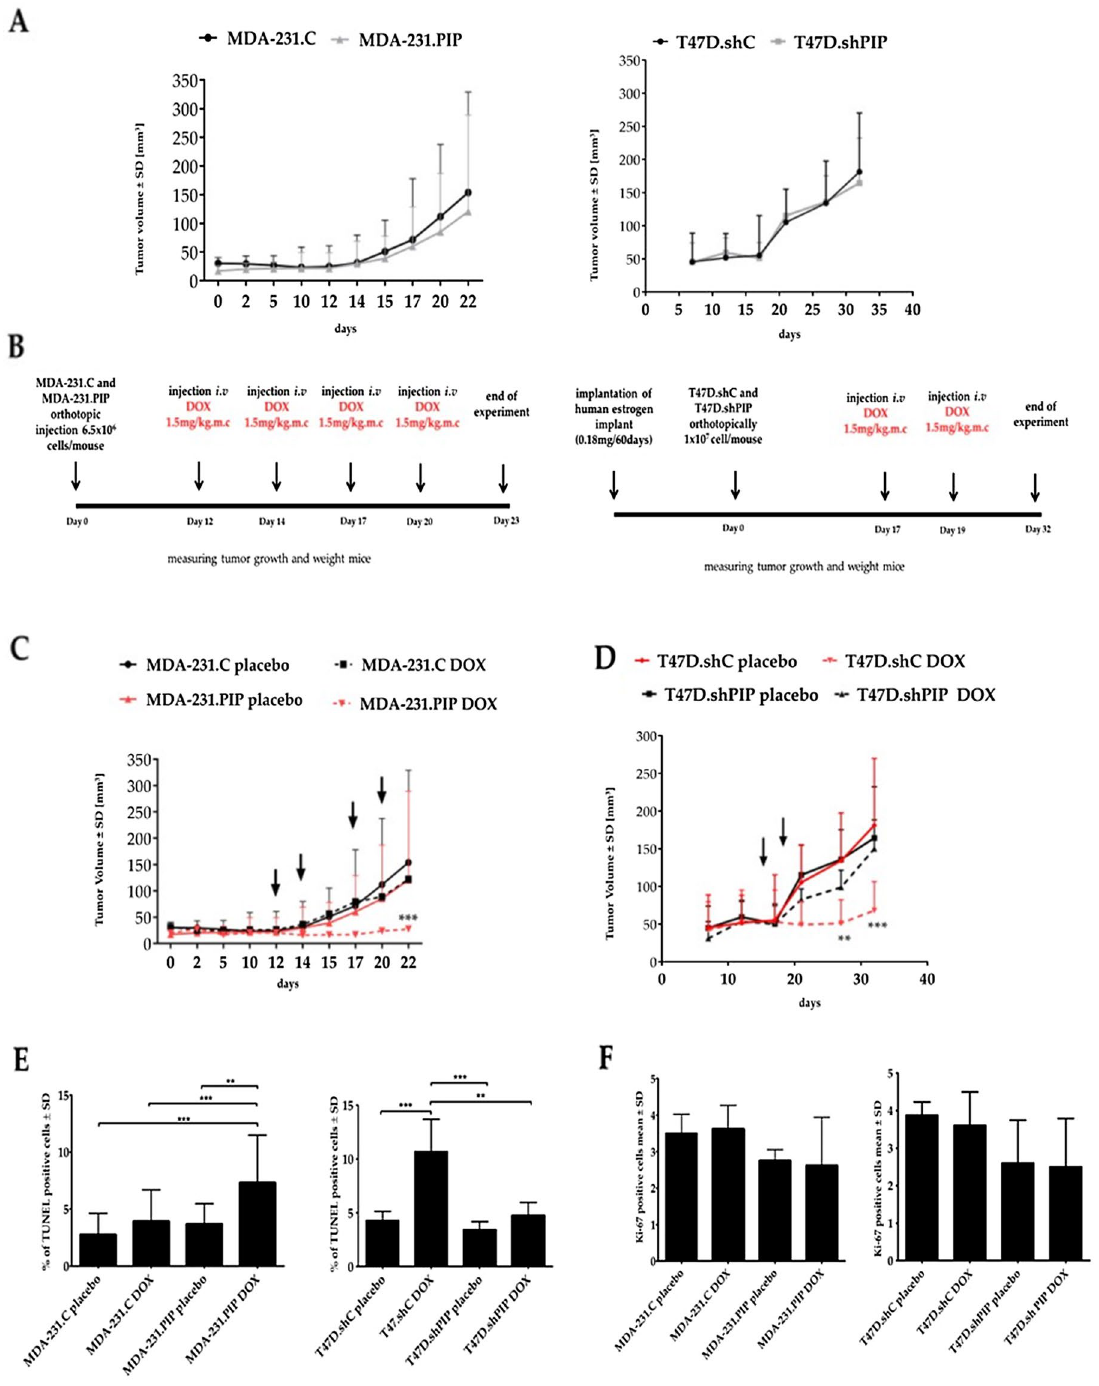
Figure 4. ( A ) Xenograft tumor growth of MDA-231.PIP with overexpression of PIP and control MDA-231.C; T47D.shPIP with the suppressed expression of PIP and control T47D.shC cells in nude Crl:NU(Ncr) mice. ( B ) Mice bearing tumors were subjected to treatment with DOX. Impact of DOX on the growth of ( C ) MDA-231. PIP, MDA-231.C cells, ( D ) T47D.shPIP and T47D.shC cells. MDA-231.PIP/placebo and MDA-231.C/placebo— mice with MDA-231.PIP or MDA-231.C tumors treated with placebo. MDA-231.PIP/DOX and MDA-231.C/ DOX—mice with MDA-231.PIP or MDA-231.C tumors treated with DOX; T47D.shPIP/placebo or T47D.shC/ placebo mice with T47D.shPIP or T47D.shC tumors treated with placebo. T47D.shPIP/DOX and T47D.shC/ DOX—mice with T47D.shPIP or T47D.shC tumors treated with DOX. Data were shown as the mean tumor volume for the group of mice (n = 10–12 for MDA-231 cells and n = 7–8 for T47D cells) ± SD at each indicated time point (arrows). Data were analyzed using Graphpad prism 7.0 two-way Anova Dunnett’s post test. ( E ) The number of apoptotic cells and ( F ) Ki-67-positive cells in MDA-231.PIP, MDA-231.C, T47D.shPIP, and T47D.shC tumors determined by TUNEL assay and IHC staining with monoclonal antibody against Ki-67 and compared by the Mann–Whitney U test (** p < 0.01, *** p <